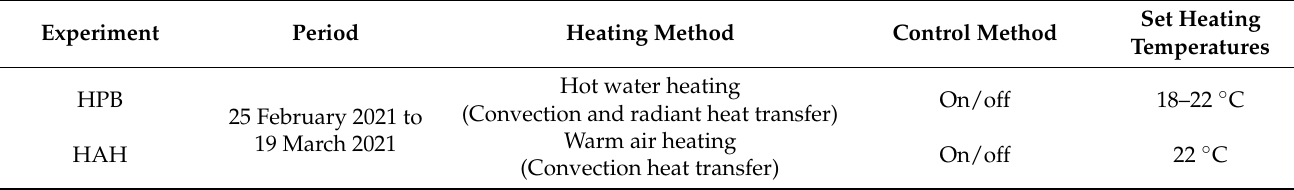
Table 8. Heating experiment information.